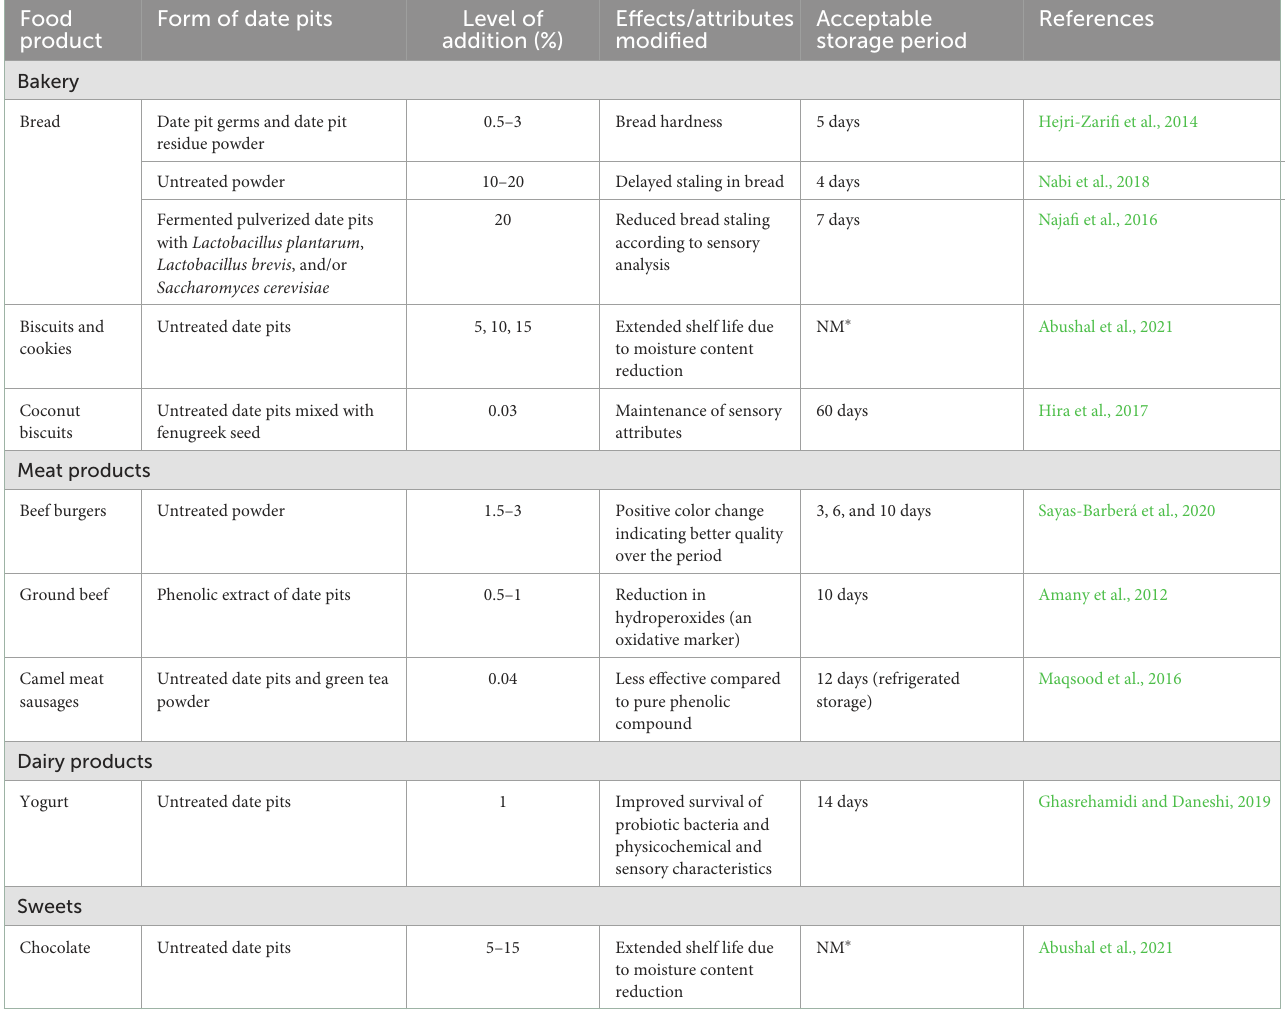
TABLE 3 Effects on shelf life of adding date pits to foods in various food